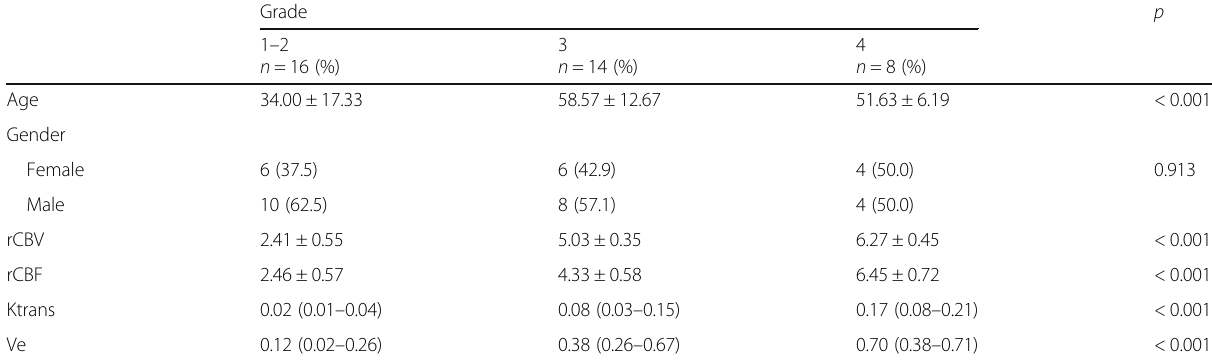
Table 2 Distribution of findings according to grade subgroups